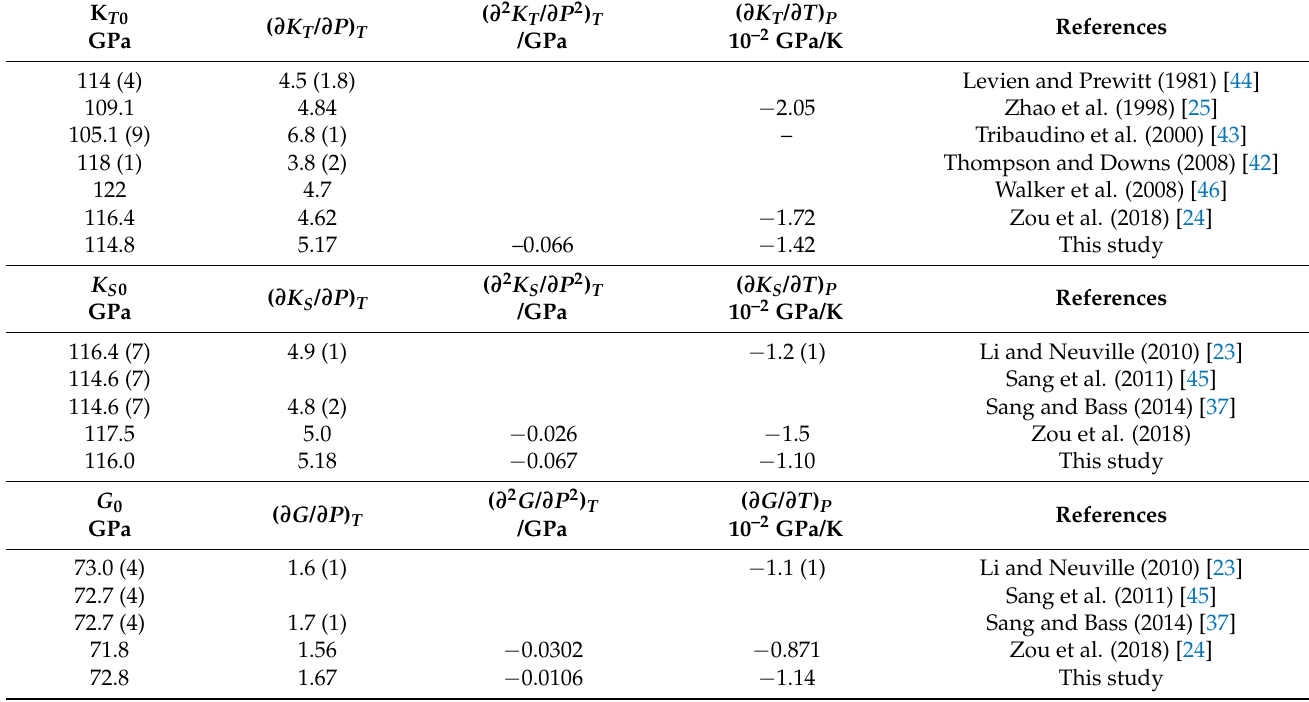
Table 2. Elastic moduli of diopside and their first and second derivatives with respect to pressure and temperature. K T 0